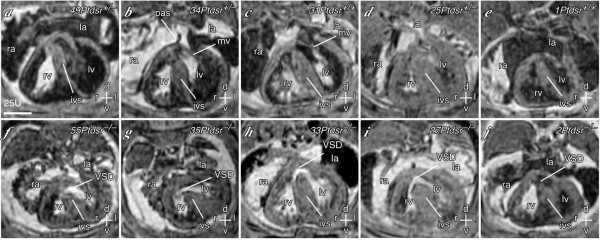
Identification of cardiac malformations in Ptdsr-/- embryos using multi-embryo MRI (a–e) Transverse thoracic sections showing the heart of heterozygous or wild-type control embryos from each litter. The left and right ventricles (lv, rv) are separated by the interventricular septum (ivs). The left and right atria (la, ra) are also indicated, separated by the primary atrial septum (pas). (f–i) Corresponding sections through littermate Ptdsr-/- embryos, showing ventricular septal defects (VSD). Scale bar = 635 μm; axes: d – dorsal; v – ventral; r – right; l – left; a – anterior, p – posterior. Individual embryos are indicated by number.